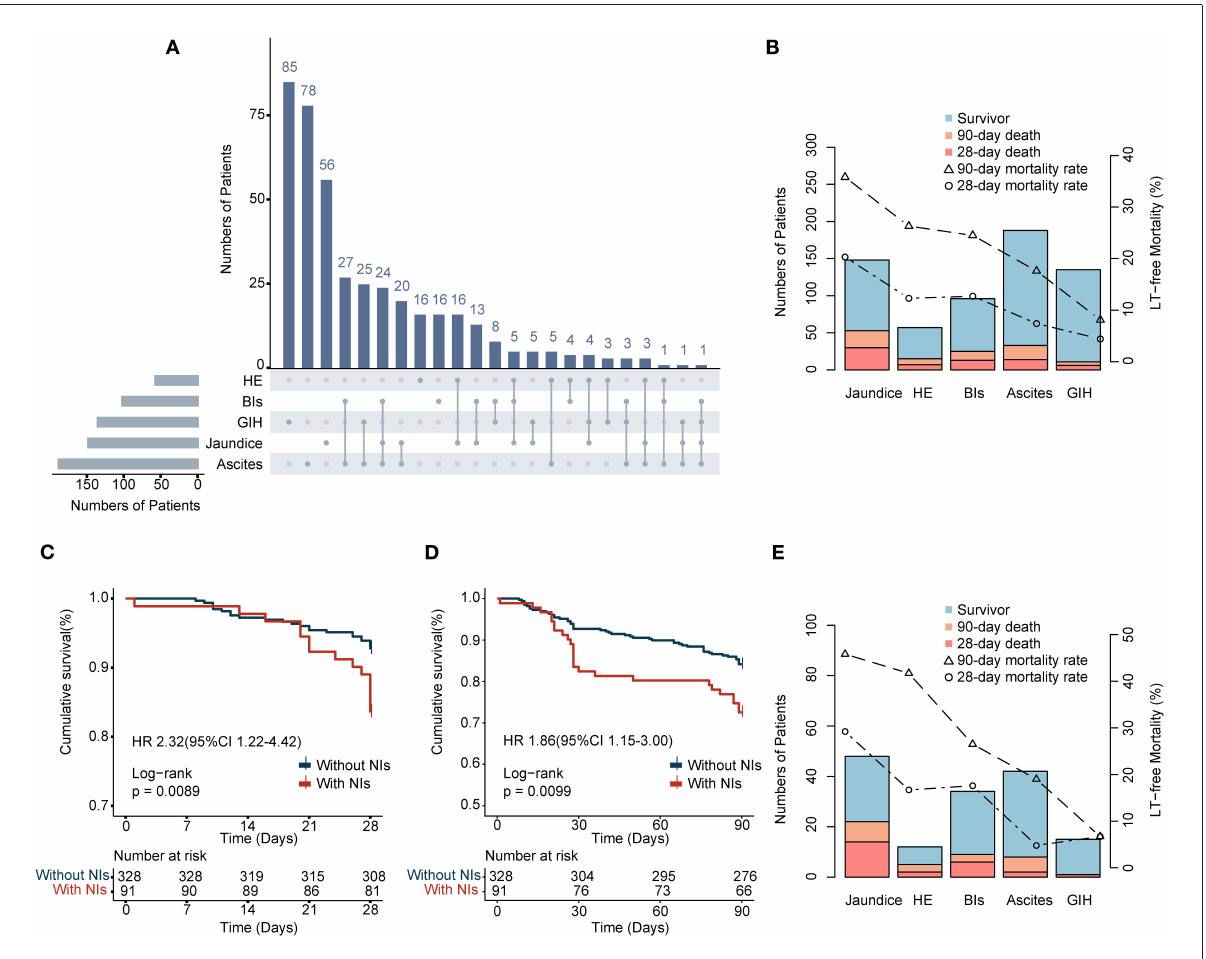
FIGURE2 (A) Stacked column chart depicting combinations of AD events in enrolled patients. (B,E) Pareto charts showing the characteristics of AD events in two cohorts and the events-specific LT-free mortality. (C,D) 28- and 90-day survival curves of enrolled patients with or without NIs.